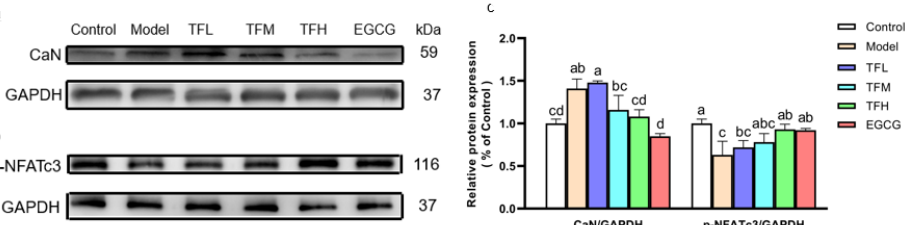
Figure 6. ( a ) CaN protein expression of H9c2 cells treated with different concentrations of TF3 and EGCG. ( b ) p-NFATc3 protein expression of H9c2 cells treated with TF3 and EGCG. ( c ) Densitometry analysis of protein bands. Control group, no ANGII treatment; Model group, ANGII 0.5 µ M induction; TFL group, TF3 1 µ M pretreatment and ANGII 0.5 µ M induction; TFM group, TF3 5 µ M pretreatment and ANGII 0.5 µ M induction; TFH group, TF3 10 µ M pretreatment and ANGII 0.5 µ M induction; EGCG group, EGCG 50 µ M pretreatment and ANGII 0.5 µ M induction. Significant differences between different treatments were shown by different letters ( p <